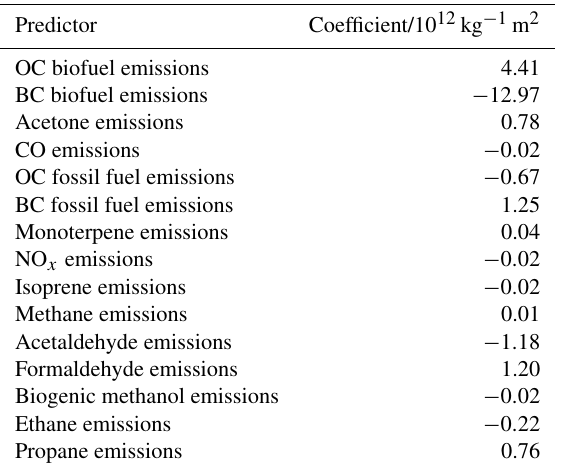
Table 3. Correlation of the missing k OH with some of the emitted species would be expected, both if the missing